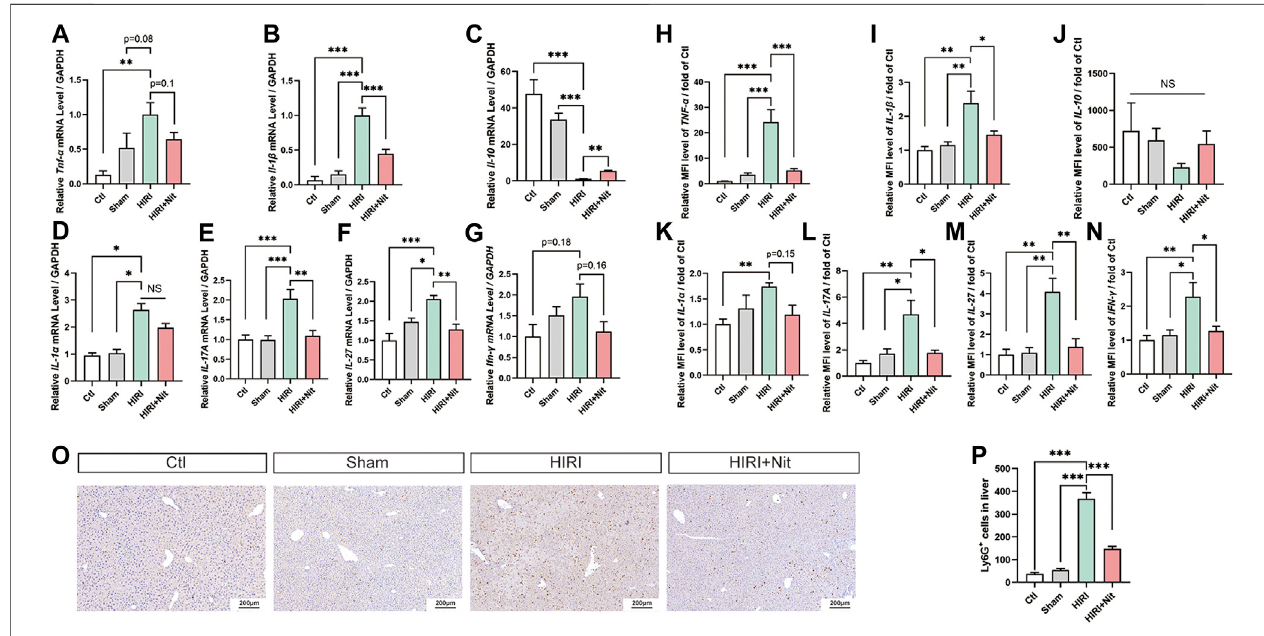
FIGURE2| DietarynitratereducedIR-associatedin fl ammatoryresponsesinmice. (A) RelativemRNAlevelof Tnf- α , (B) Il-1 β , (C) Il-10, (D) Il-1 α , (E) Il-17A , (F) Il-27 , and (G) Ifn- c . (H) PlasmalevelsofTNF- α , (I) IL-1 β , (J) IL-10, (K) IL-1 α , (L) IL-17and (M) IL-27,and (N) IFN- c . (O) ImmunohistologyofLy6GinCtl,Sham,HIRI,andHIRI+ Nit groups at 100 × magni fi cation. (P) Quantitative analysis of Ly6G-positive cells. Data are expressed as mean ± SEM, *p ＜ 0.05, **p ＜ 0.01, ***p ＜ 0.001, and NS denotes no signi fi cance.